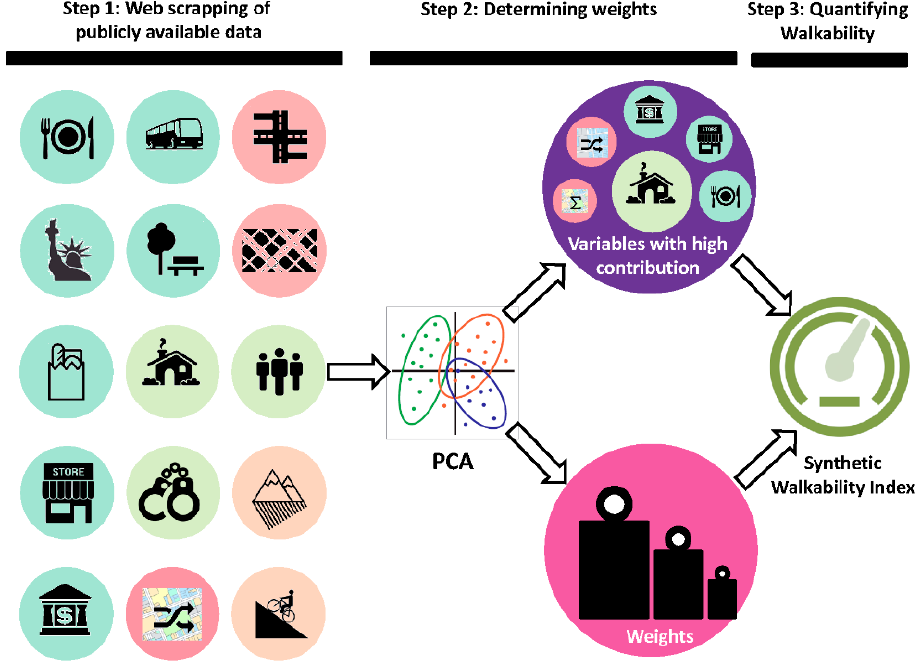
Figure 2. Flowchart of the proposed data-driven framework for walkability quantification.